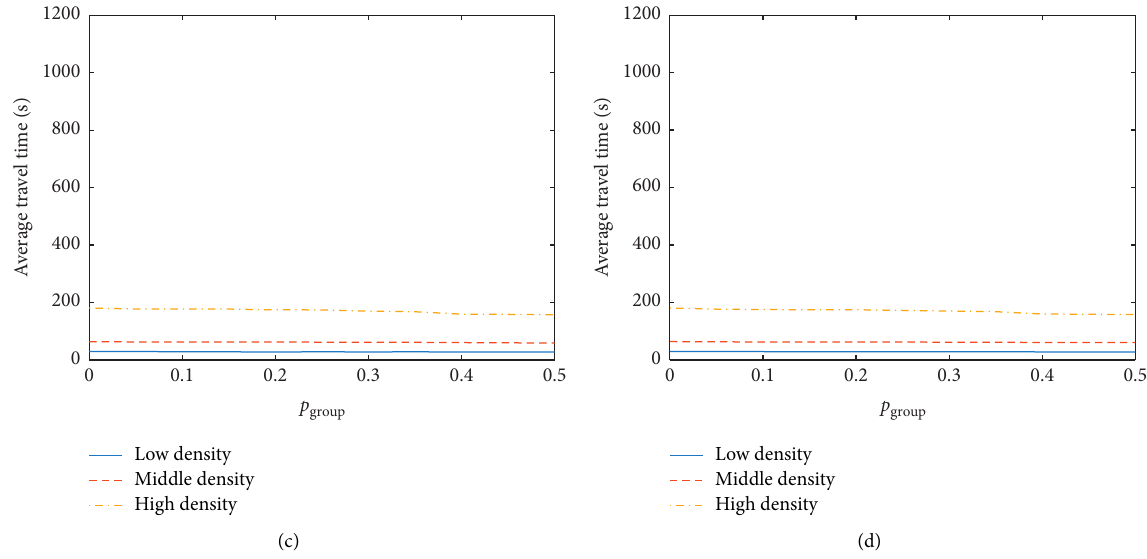
Figure 12: The average travel time under different group probabilities. (a, b) Shoulder group behavior and (c, (d) following group behavior. The group sizes are 2 in (a) and (c) and 3 in (b) and